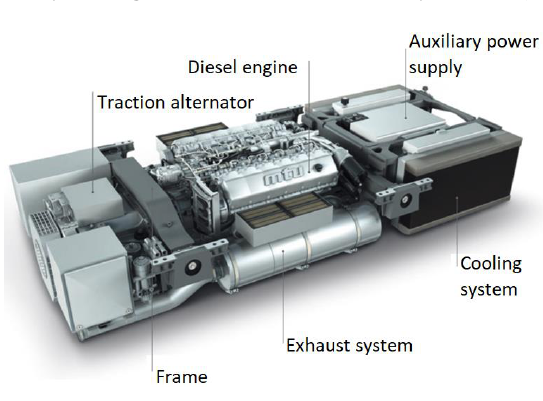
Fig. 9. MTU series 1600 PowerPack [20]